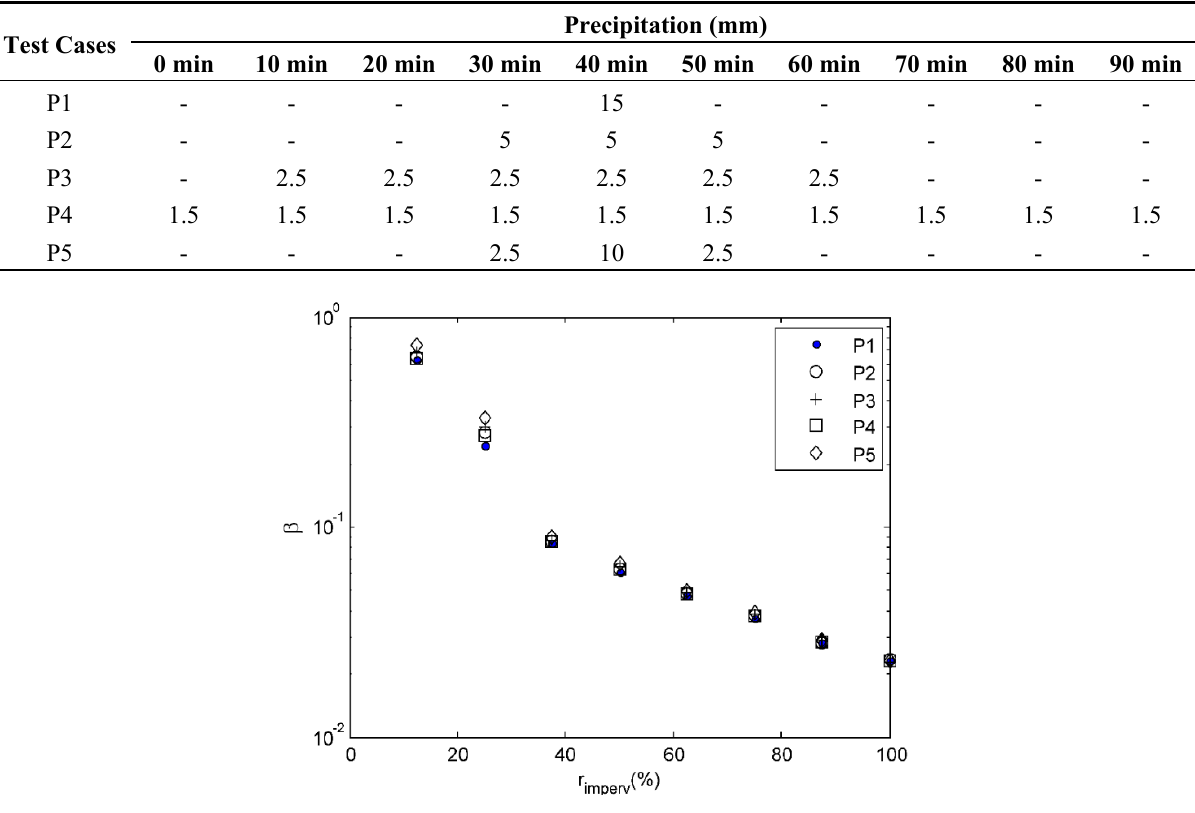
Figure 9. Corresponding Gibbsian models ( β ) to a fully looped network ( S c = 10 − 4 ) depending on the imperviousness ratio and temporal rainfall